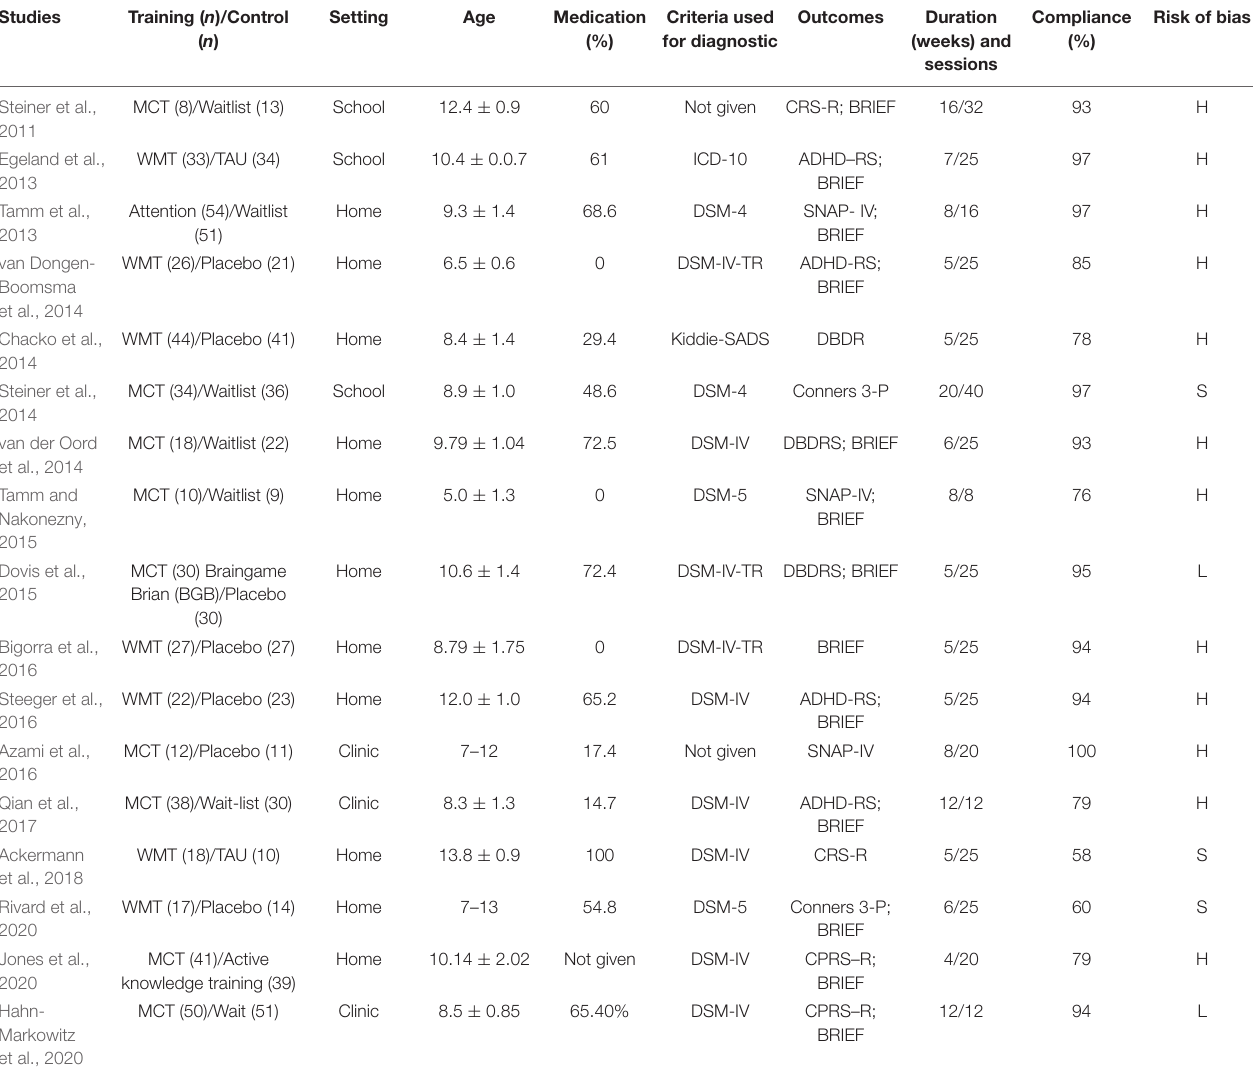
TABLE 1 | Characteristics of the studies included in the analysis. Training ( n )/Control Setting Medication ( n )